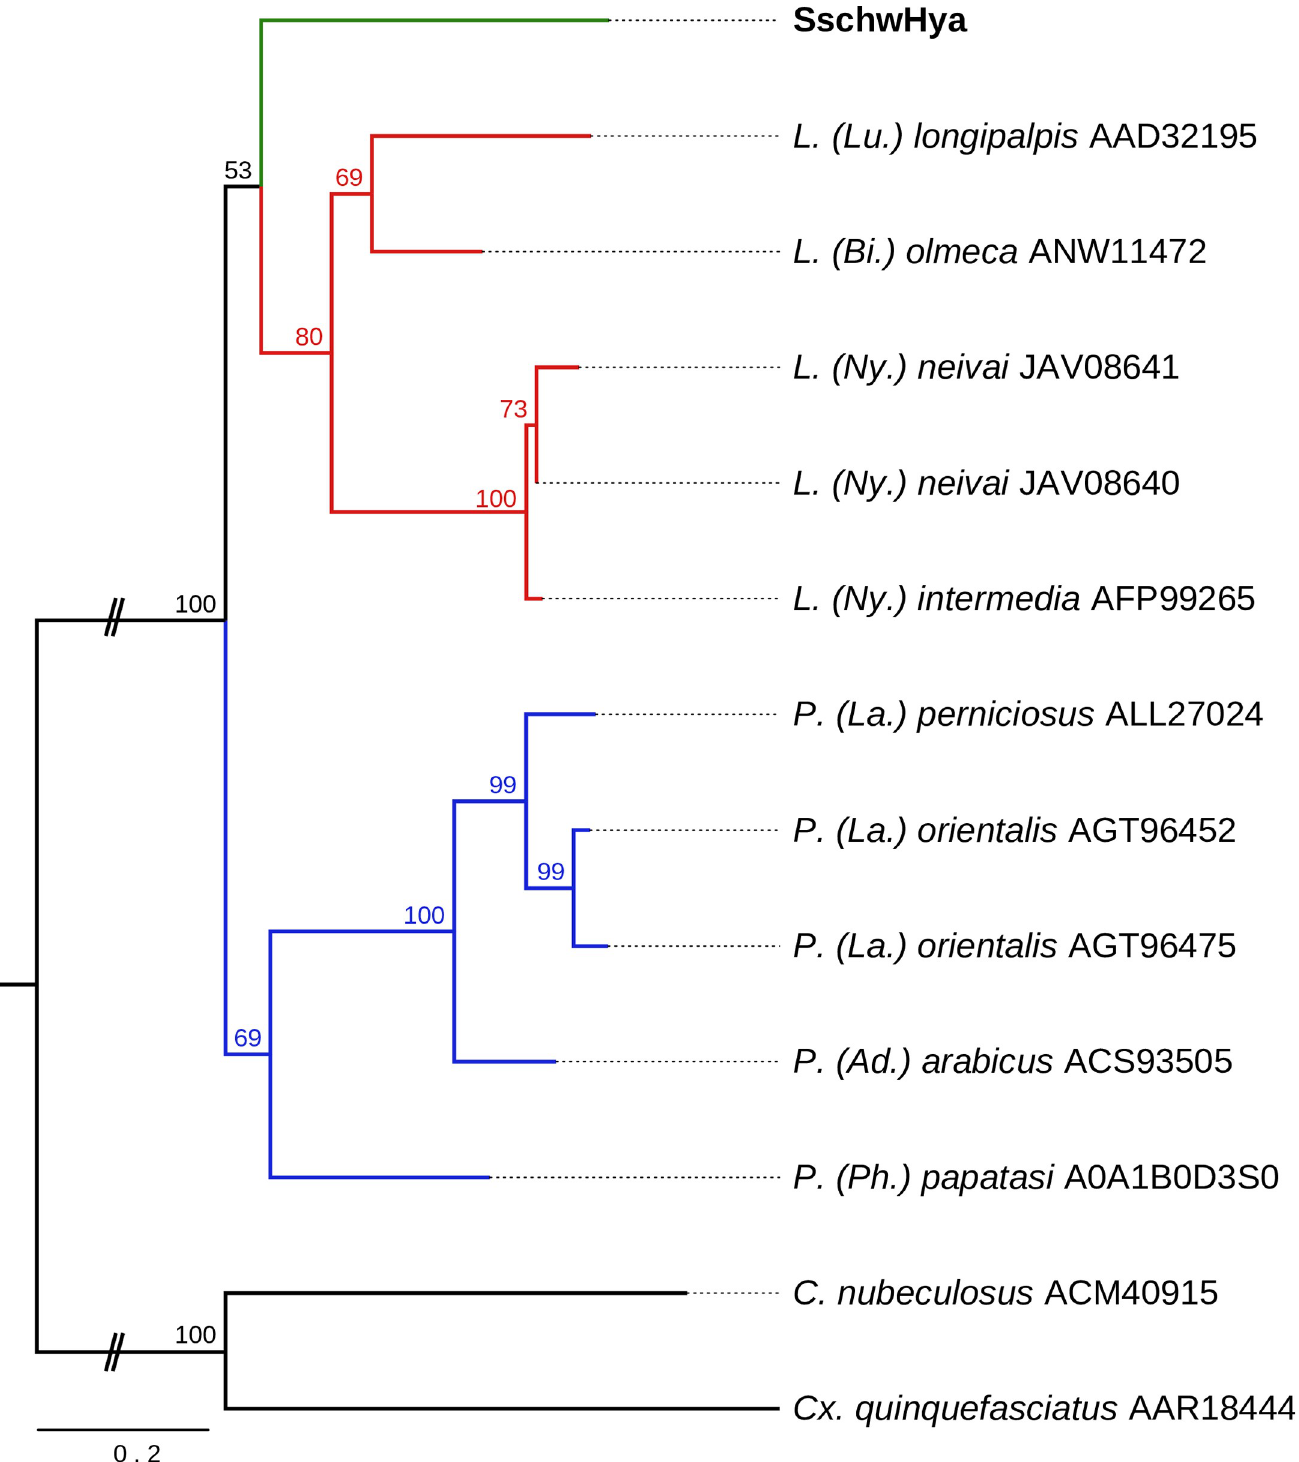
Fig 8. Phylogenetic comparison of hyaluronidase. The phylogenetic tree with 13 sequences was based on MAFFT alignment with BMGE (threshold 0.4) containing 270 aa sites, 154 parsimony-informative sites, 56 singleton sites and 61 constant sites. For rooting the tree, the Culex quinquefasciatus (AAR18444) and Culicoides nubeculosus (ACM40915) sequences were used (branches in black). For more detail see Fig 2 legend.